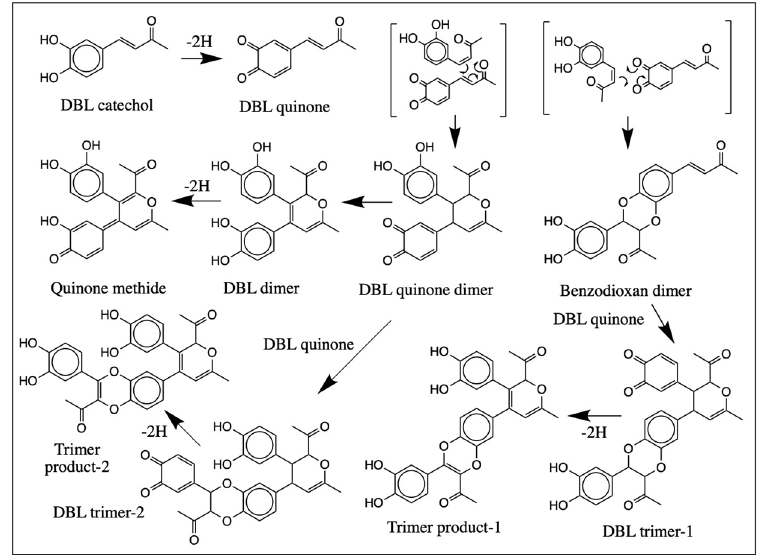
Figure 14. Proposed mechanism for the oxidative transformation of DBL catechol. Oxidation of DBL catechol produces the corresponding quinone which is very reactive and reacts instantaneously with the parent compound forming dimers, probably via ionic Diels-Alder addition reactions. The further oxidation of these dimers and coupling to another molecule of DBL quinone produces trimeric products. These additions are all nonenzymatic and hence, non-stereoselective multiple isomeric products are generated in each case.